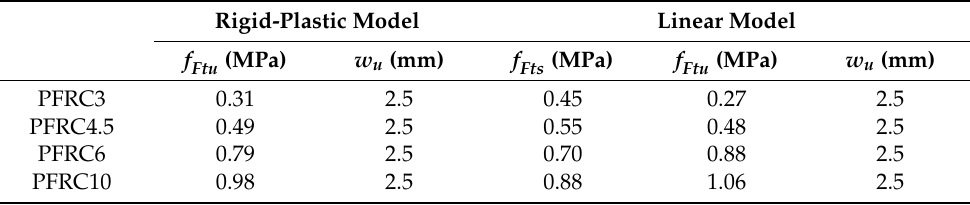
Table 1. Parameters of the rigid-plastic and the linear models for each fibre dosage of PFRC.